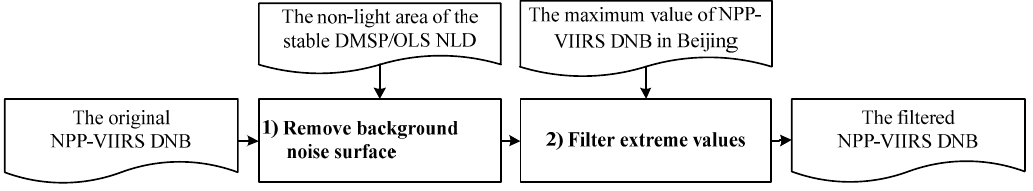
Figure 2. Pre-processing procedure of the original nighttime light image composited by the Day/Night Band of the Visible Infrared Imaging Radiometer Suite on the Suomi National Polar-orbiting Partnership Satellite (the NPP-VIIRS DNB data).